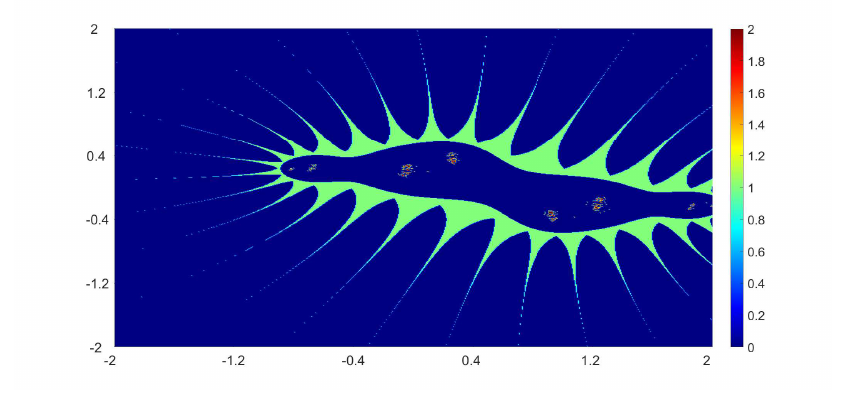
Figure 8. Example 2(d).